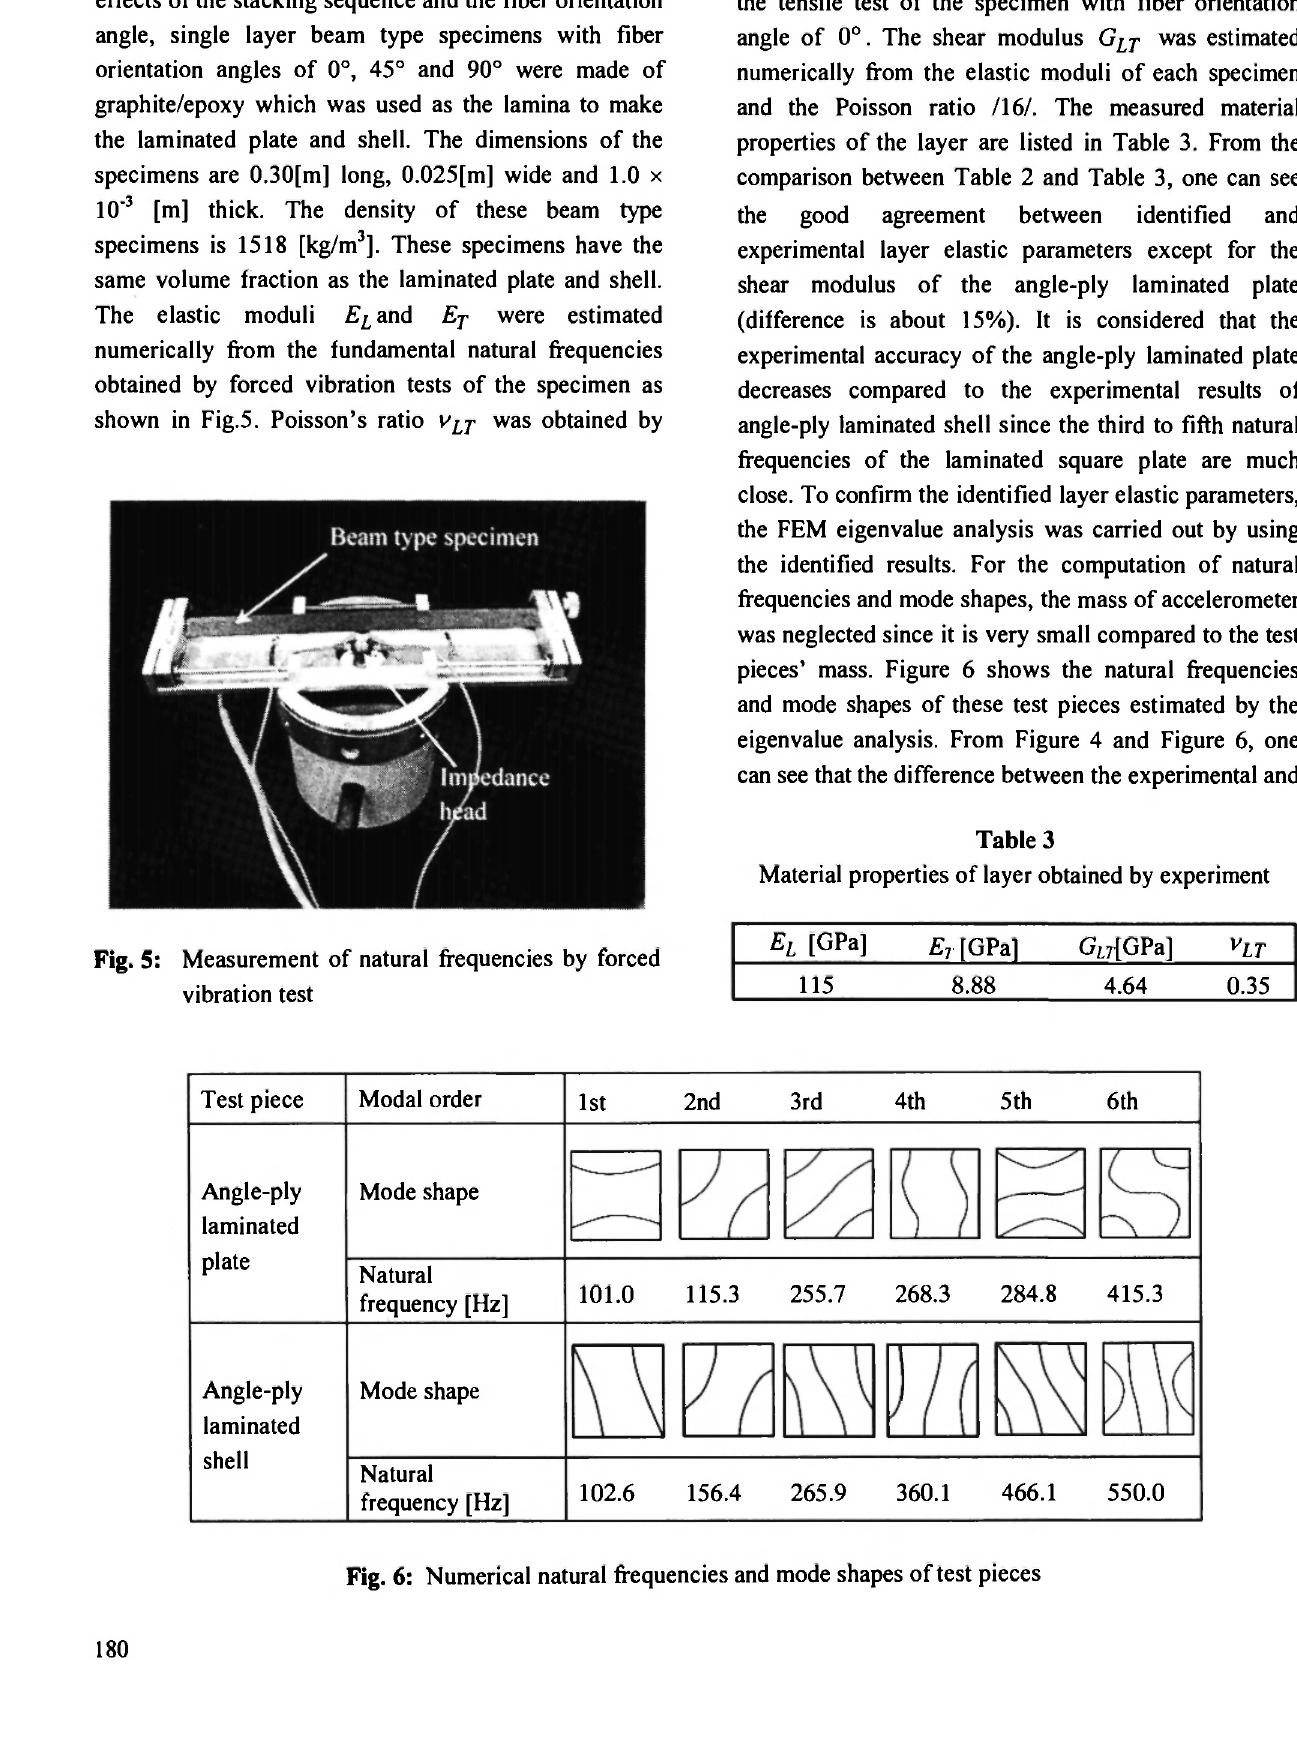
Fig. 5: Measurement of natural frequencies by forced